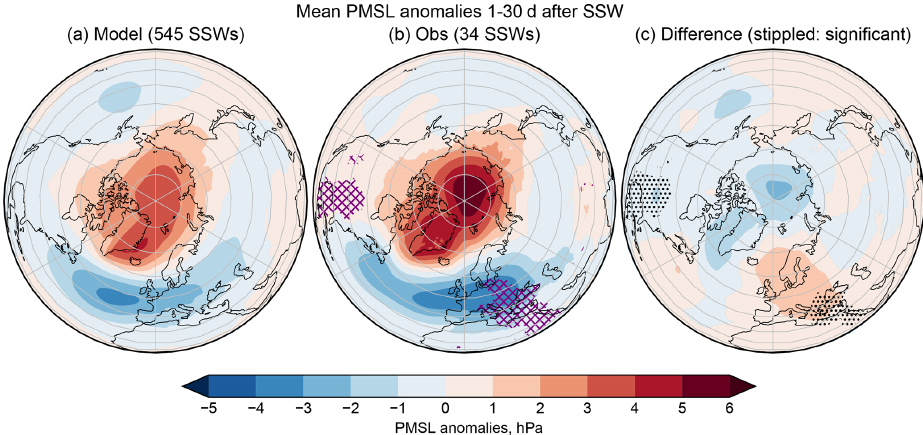
Figure 3. Surface responses to SSW events. The left and centre panels show the composite mean PMSL fields for (a) the model and (b) observations in the 30d after an SSW. In the observational panel, regions where the data exceed the 95% range of composites from the hindcast resamples are marked with purple cross-hatching. The right-hand panel (c) shows the difference between the mean fields (model minus observations), with stippling indicating where the differences are statistically